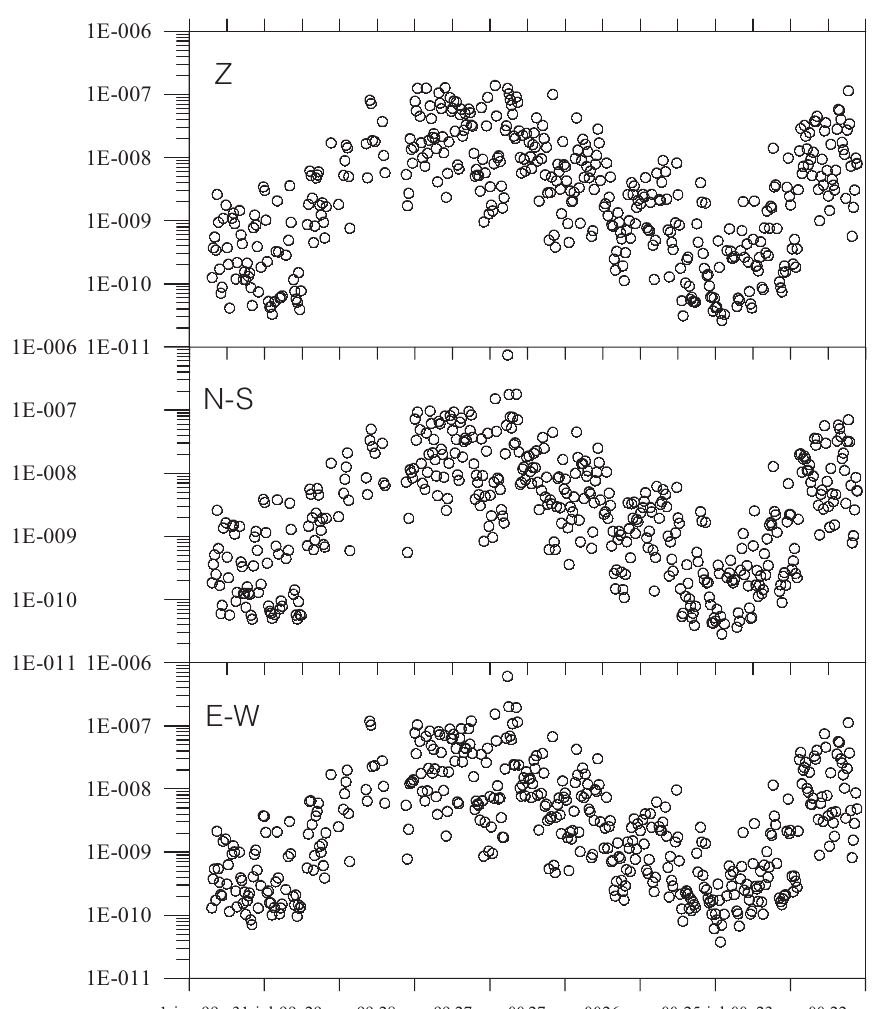
Fig. 7. Seasonal variation of the velocity power spectra peak for three-component primary